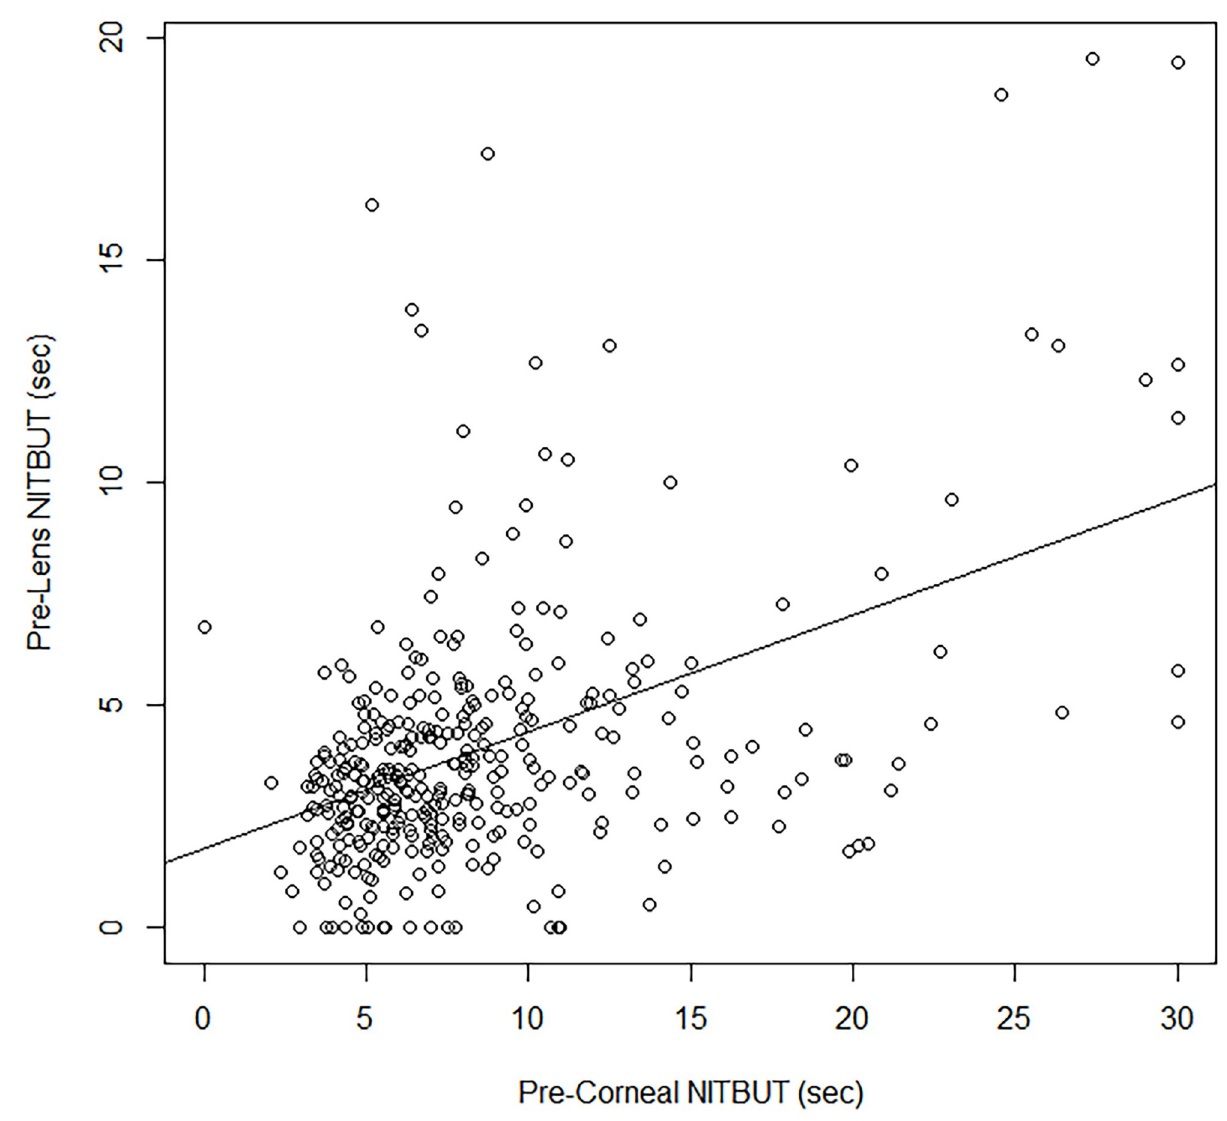
Fig 2. Pre-corneal vs. pre-lens NITBUT at 10 min post-contact lens insertion (n = 348).